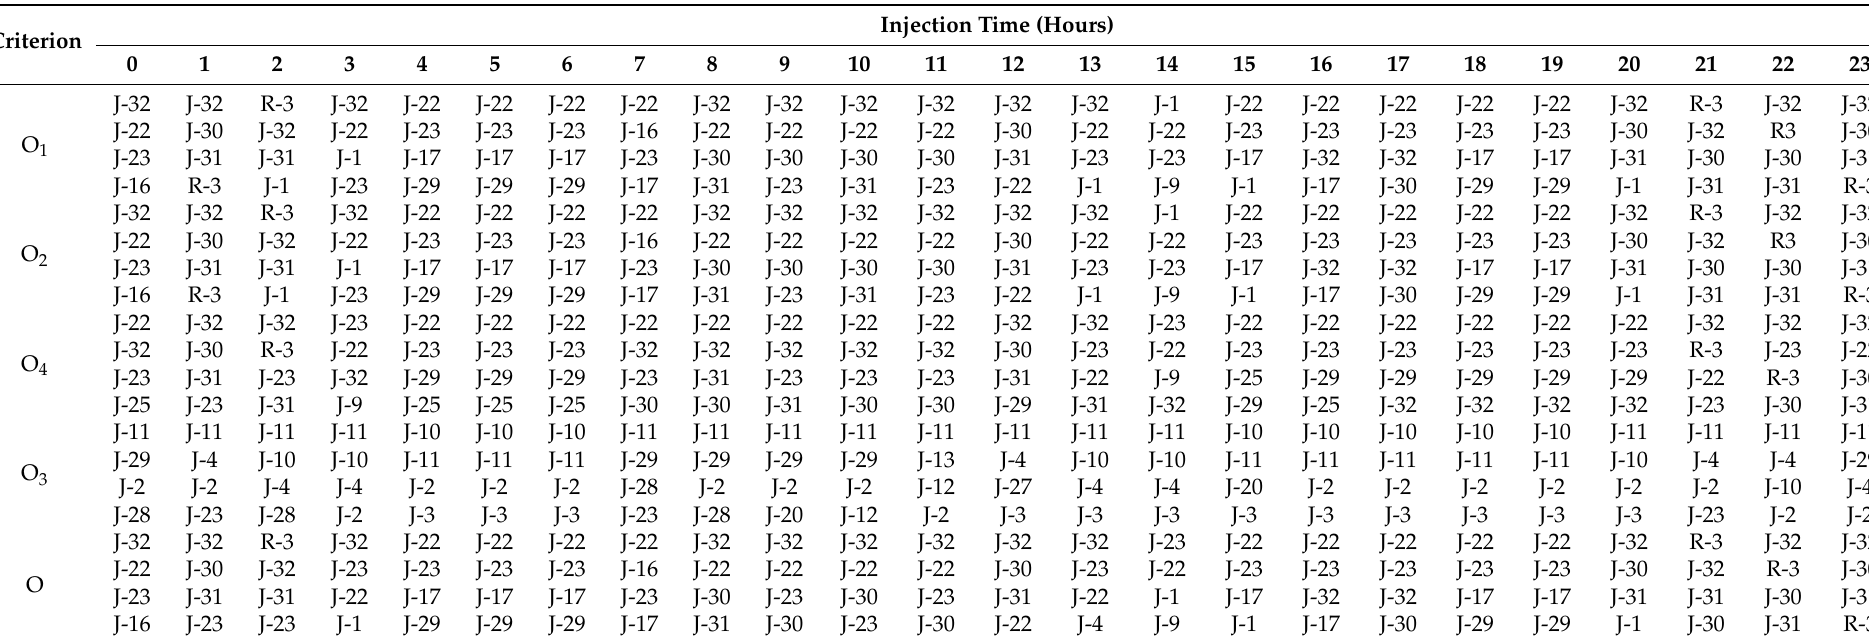
Table 3. The four nodes with the lowest values for O 1 , O 2 , O 4 and O and the highest values for O 3 , for all injection times (from 0 h to 23